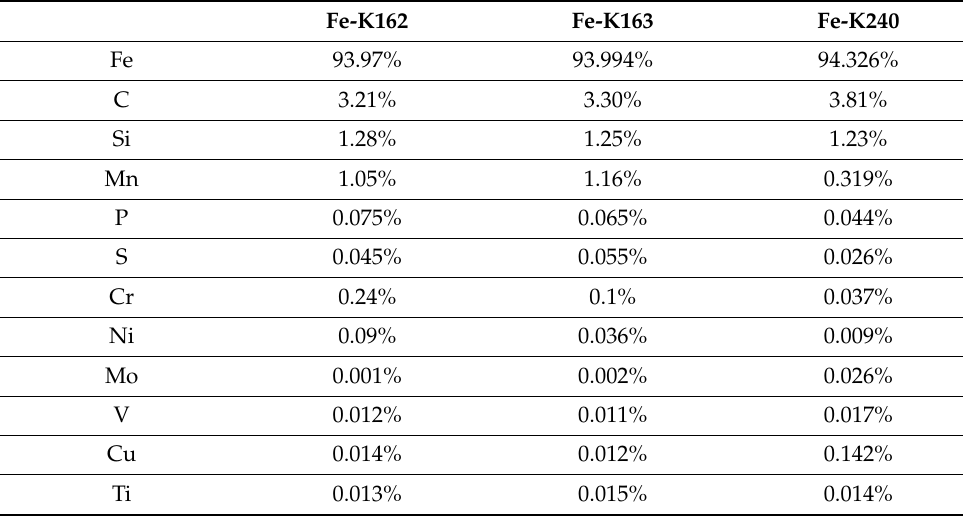
Table 2. Proportion of the elements in metallic alloys.